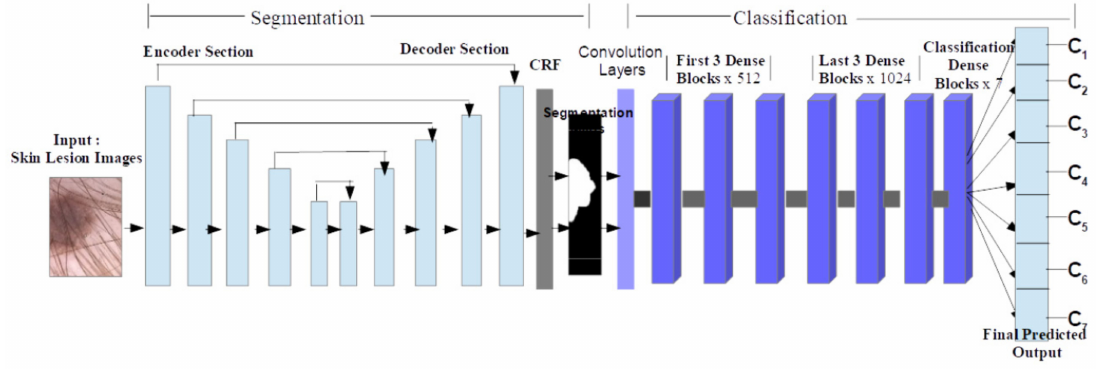
Figure 25. The architecture of the proposed system for skin lesion classification